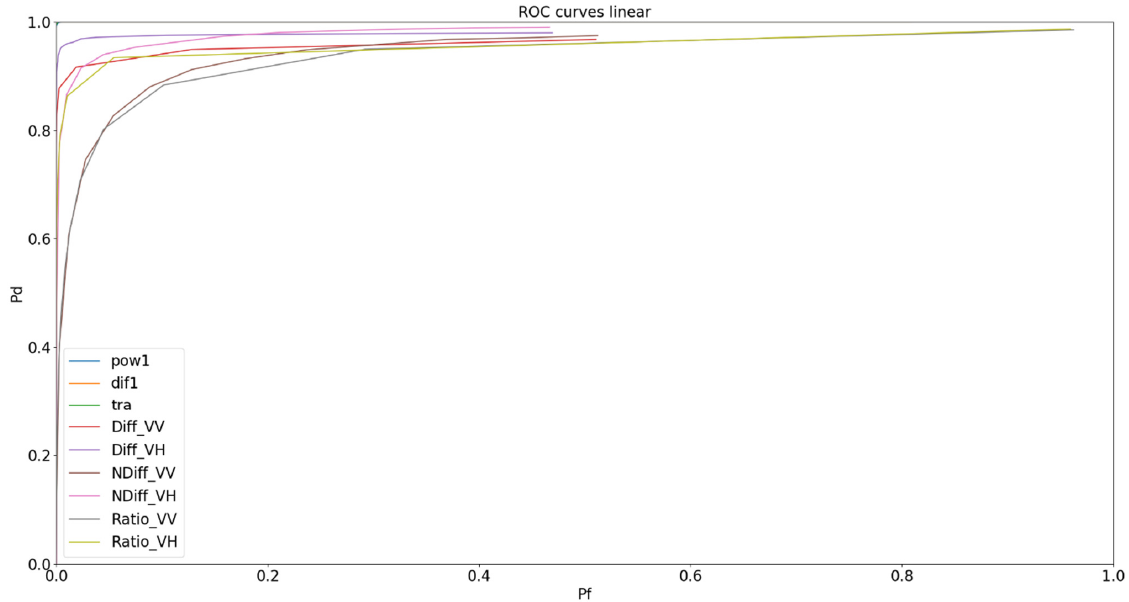
Figure 12. ROC Curve in Log10 showing change detectors used on 19 January 2020 paddy & 24 April 2020 data: Difference VV and VH (Diff_), Ratio VV and VH (Ratio_), Normalised Difference (NDiff_), Power Difference (Dif1), Power Ratio (Pow1) and Trace (HLT).